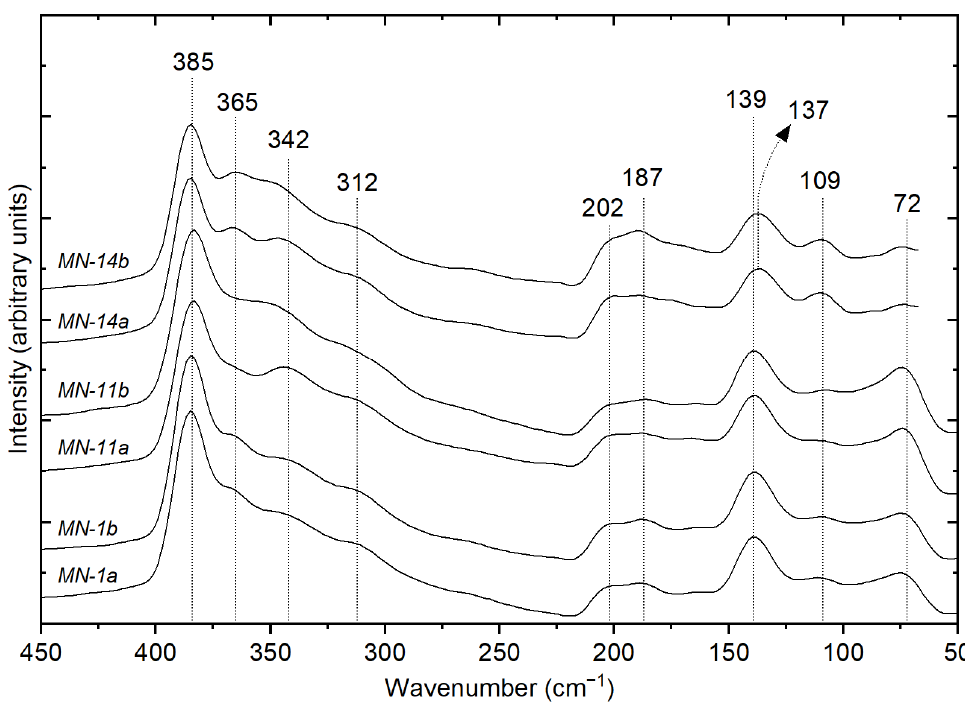
Figure 12. Raman spectra of the tennantites from the Mănăilă ore deposit. The spectra are displayed vertically for clarity. Table 6. Electron microprobe analyses of tennantites (wt.%).